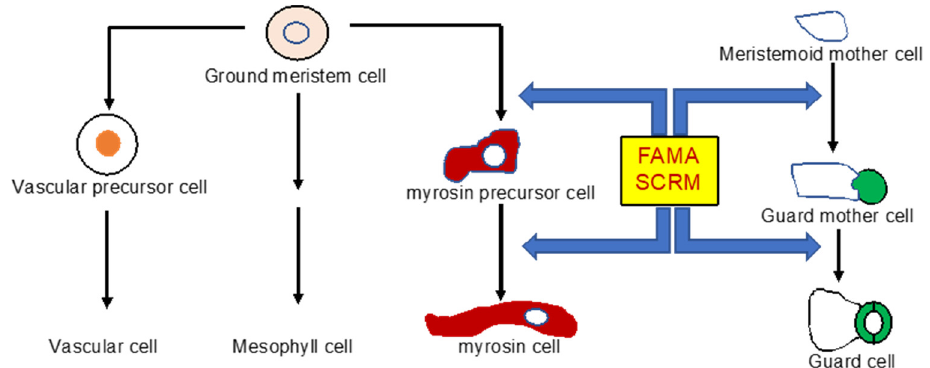
Figure 3. Development of myrosin cells in Arabidopsis . Myrosin cells are differentiated from ground meristem cells, which are also the mother cells for vascular cells and mesophyll cells. The FAMA and SCRM transcription factors function as master regulators of both myrosin and guard cell dif- ferentiation.